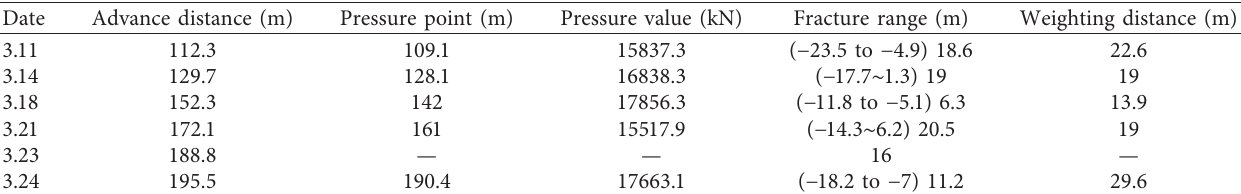
Figure 5: Resistance curve of the on-site monitoring bracket. (a) 71# bracket and (b) 72# Table 2: Statistical table of periodic pressure and surface cracks.